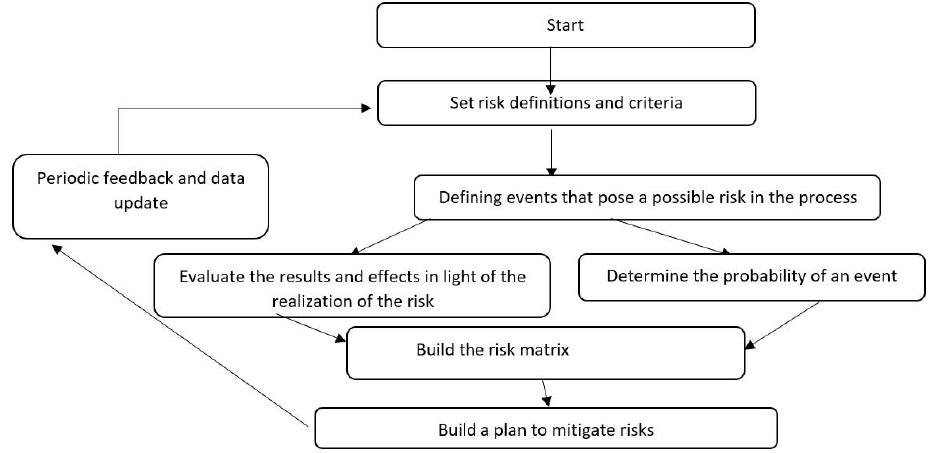
Figure 1. Risk assessment process flow chart.